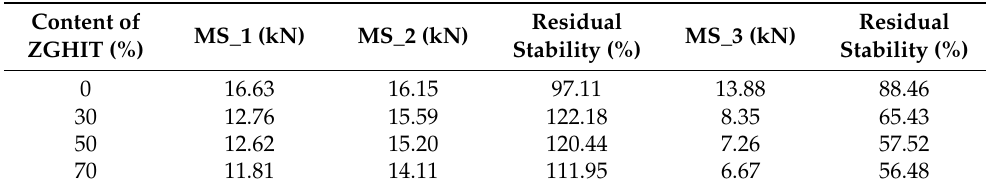
Figure 7. Results of the low-temperature splitting test. ( a ) Splitting tensile strength. ( b ) Modulus of failure strength. Table 3. Results of water immersion Marshall